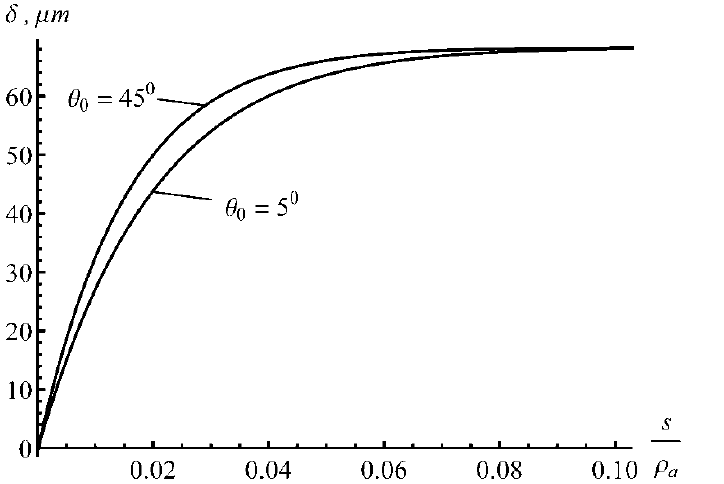
Figure 5. Thickness of the layer of intensive plastic deformation near the entrance to the die for the von Mises yield criterion.